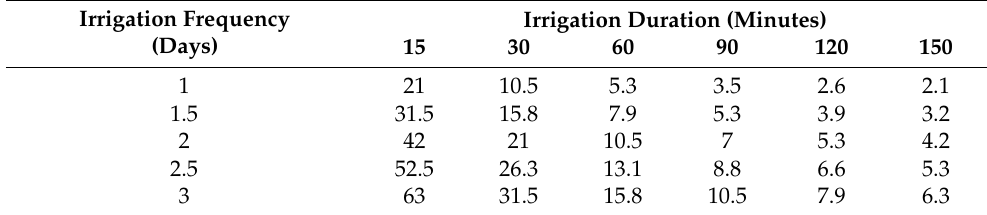
Irrigation Duration